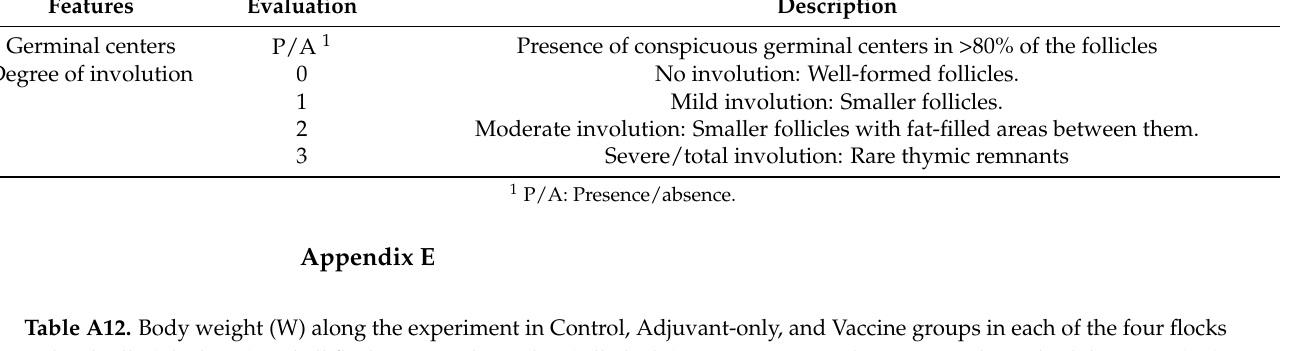
Table A12. Body weight (W) along the experiment in Control, Adjuvant-only, and Vaccine groups in each of the four flocks individually (Flock 1–4) and all flocks grouped together (All Flocks). Data represented as mean and standard deviation (SD). Group